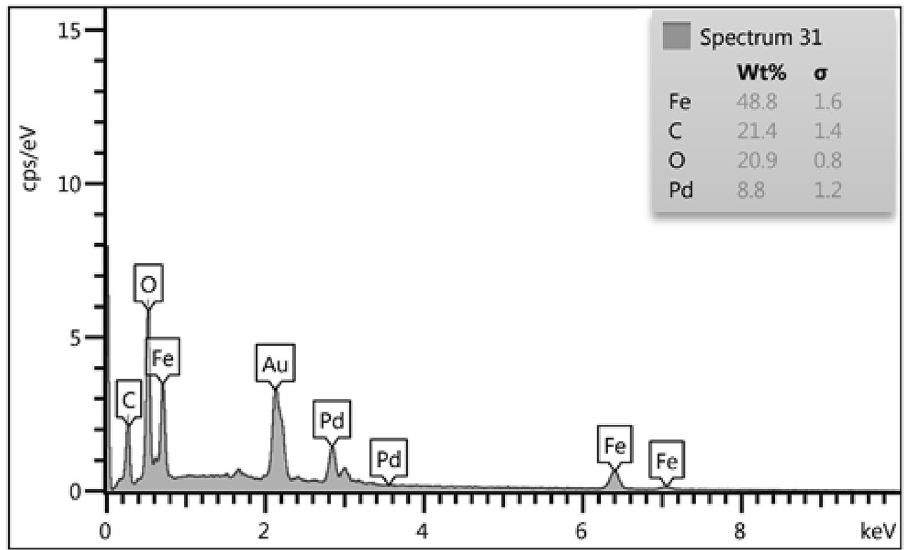
Figure 4. EDX of the Fe 3 O 4 @ Fritillaria /Pd